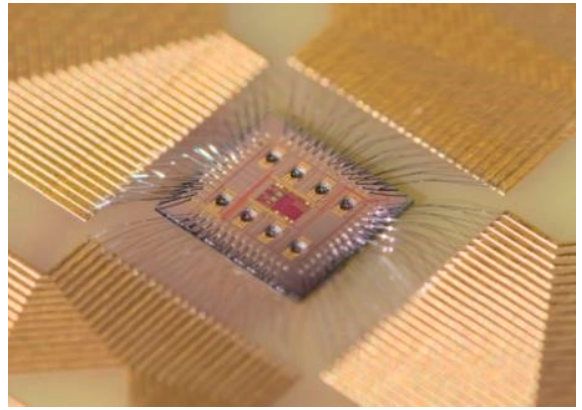
Figure 1. Chemical sensor device comprising an array of 8 µhps for a total of 16